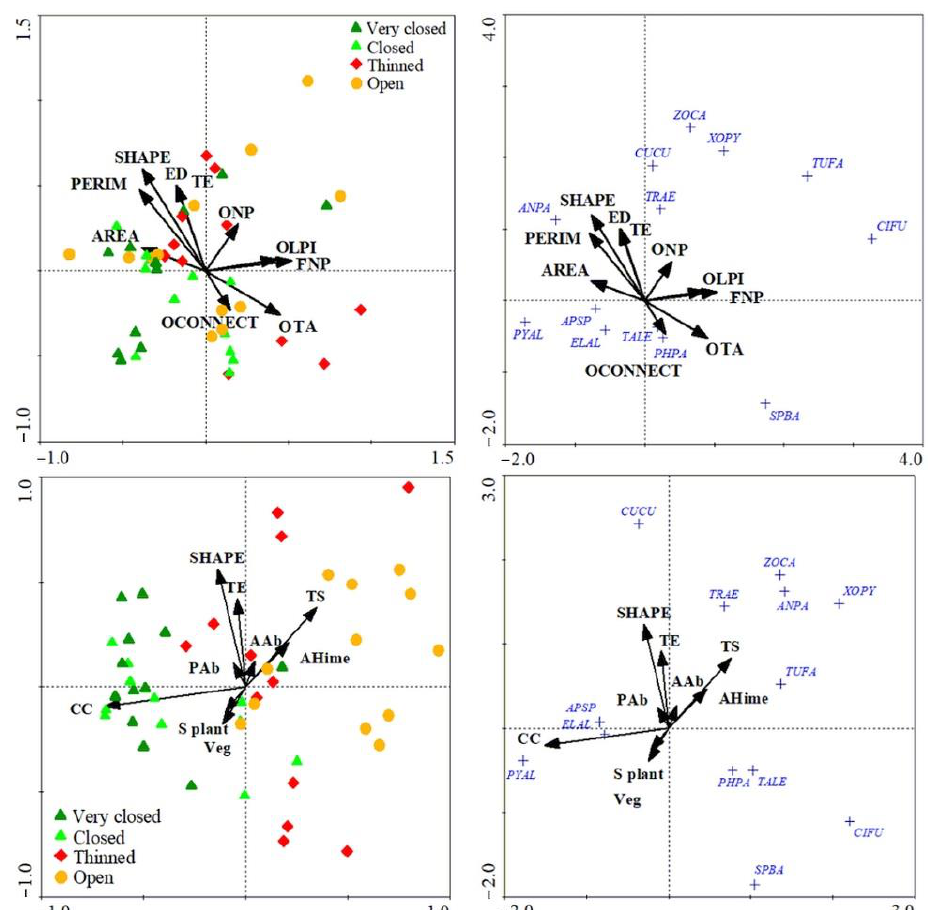
Figure 4. Canonical correspondence analysis (CCA) using landscape variables (superior panels) and a combination of landscape variables and stand characteristics (inferior panels) for the four analyzed Nothofagus antarctica forests (Very Closed, Closed, Thinned, and Open) in Tierra del Fuego, Argentina, showing plots and explanatory variables to the left, and species and explanatory variables to the right. Landscape variables: AREA = area of forest patch; PERIM = perimeter of forest patch; SHAPE = shape of forest patch; FNP = number of forest patches; OTA = surface of open areas; ONP = number of open area patches; OLPI = largest patch index of open areas; OCONNECT = connectivity of open areas; TE = total edge; DE = edge density. Stand characteristics: CC = canopy cover; TS = cover of tree sapling; S plant = richness of plants consumed by birds; Veg = cover of plant consumed by birds; AAb = abundance of arthropods captured by attraction traps; AHyme = proportion of Hymenoptera captured by attraction traps; PAb = abundance of arthropods captured by pitfalls. Species acronyms are shown in Table 2. Vectors of explanatory variables were rescaled for better rep- resentation.